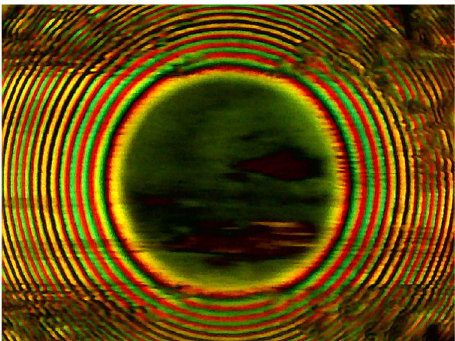
Fig. 22 Interferograms and scratches of glass disk after 300th cycle under pure rolling reciprocating motion (Centoplex 3, v max = 0.1 m/s, w = 15 N, T = 0.5 s, L = 12.5 mm).